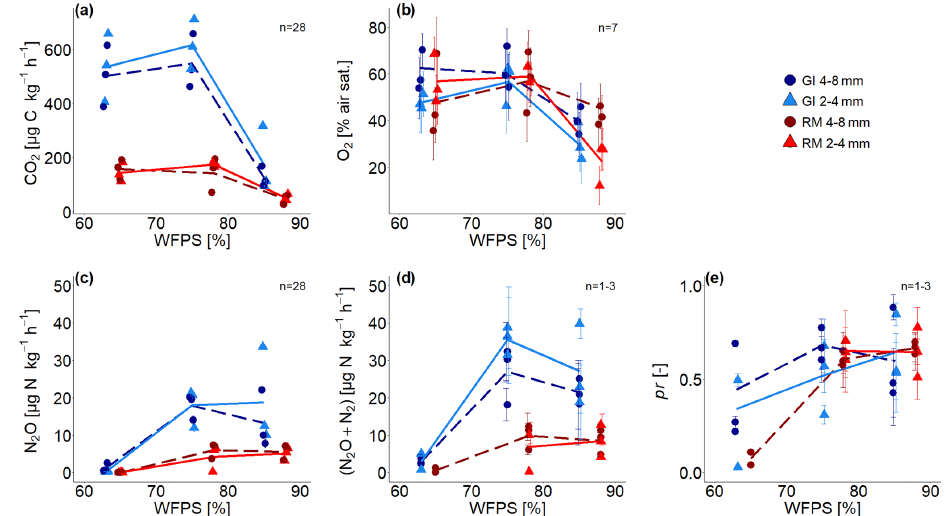
Figure 3. (a) Average CO 2 fluxes, (b) average O 2 saturation, (c) average N 2 O and (d) (N 2 O + N 2 ) fluxes, and (e) average product ratio (pr) [N 2 O / (N 2 O + N 2 )] as a function of water-filled pore space (WFPS) for two repacked aggregate sizes (2–4 and 4–8mm) from Rotthalmün- ster (RM) and Gießen (GI) soil. Symbols depict the average values for each of the three individual replicates, with error bars showing the standard error in the mean; standard error in (a) and (c) are of fluxes measured during incubation, in (b) the standard error from measure- ments of seven sensors located within the soil core, and in (d) and (e) of three measurements during incubation time (after 2, 4, and 8d with detectable R 29 and R 30 ; n = 3 for two highest WFPSs). The number of measurements ( n ) considered for averaging is displayed in each subfigure. The lines (dashed and solid) connect the average value of three replicates at each saturation (large and small aggregates, respectively).